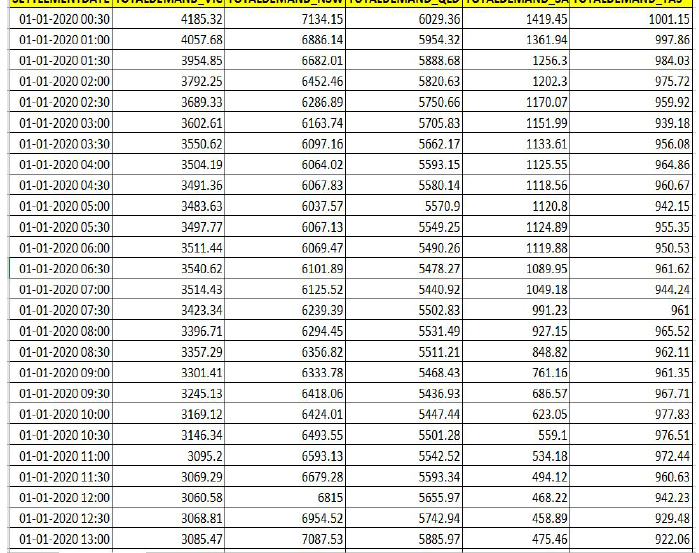
Figure 4. AEMO data- Energy Consumption Data.